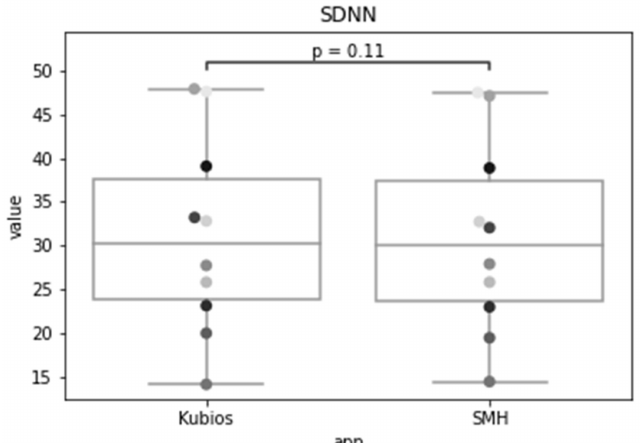
Figure 16. Standard deviation of the of all normal RR intervals (SDNN) of the same group of patients for Kubios and